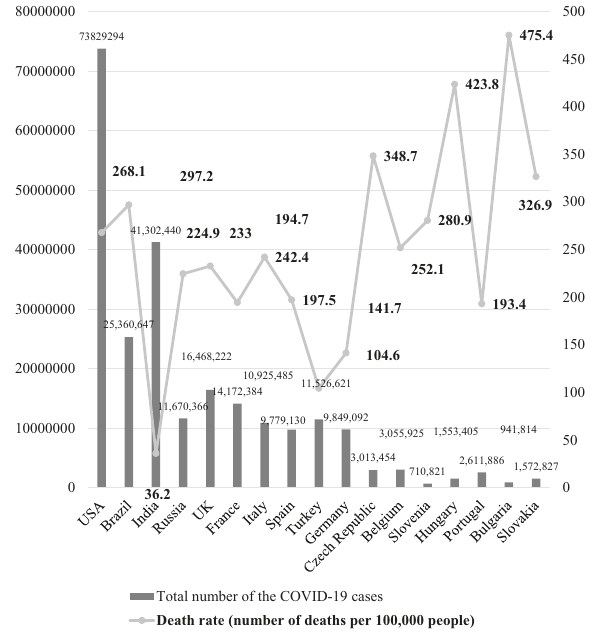
Fig. 1 Disease incidence and the speci fi c death rate from COVID-19 as of 19 March 2021, in countries with the largest number of cases and countries with the highest number of fatal cases per 100,000 people. Source : Compiled by the authors based on the BBC